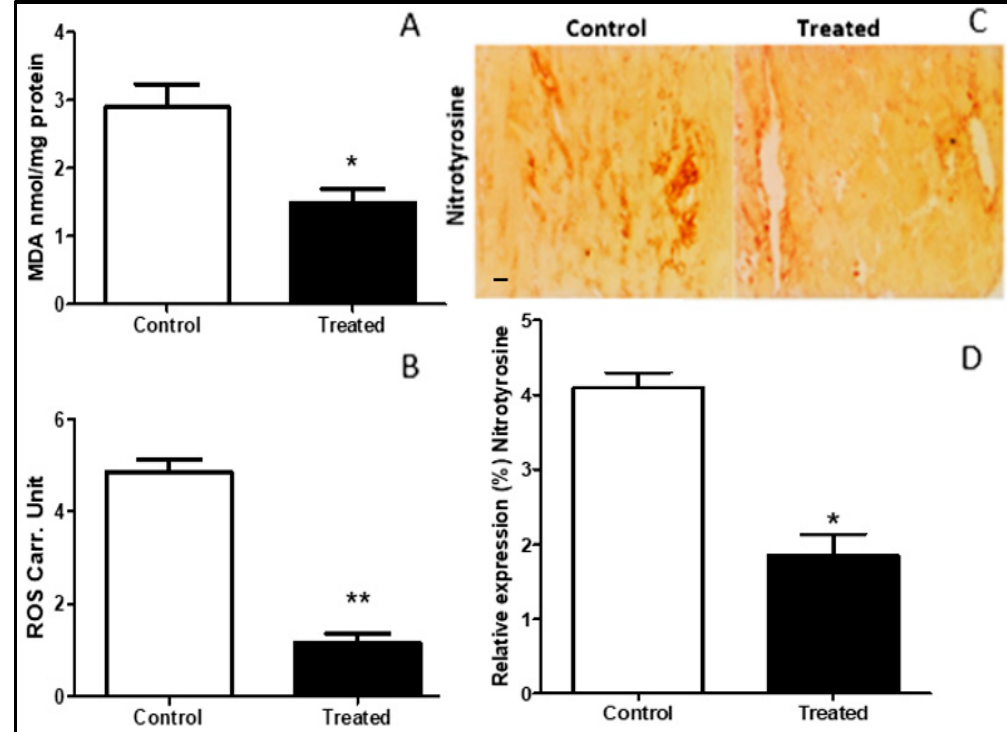
Figure 4. E ff ects of cocoa on oxidative stress on myocardial tissue rats: Lower oxidative stress was recorded in cocoa-treated rats ( n = 10) myocardial tissue as compared to control ( n = 10). ( A ) Lipid peroxidation index (TBARS) expressed as malondialdehyde (MDA) concentration measured in nmol / µ g ( p = 0.031), * p < 0.05. ( B ) Reactive oxygen species (ROS) measured as Carr. Unit (Carratelli Unit) ( p = 0.0001), ** p < 0.001. ( C , D ) Expression of nitrotyrosine staining in myocardial tissue in the control and treated groups (20 × ) ( p = 0.04), * p < 0.05. Data illustrated in the graphs are presented as mean ± SD and scale bar is 100 µ